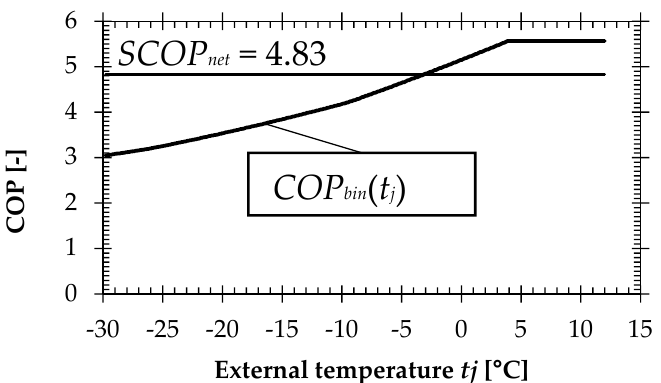
Figure 1. COP of GSHP in dependence on external temperature value, SCOP net value obtained from Equation (3).